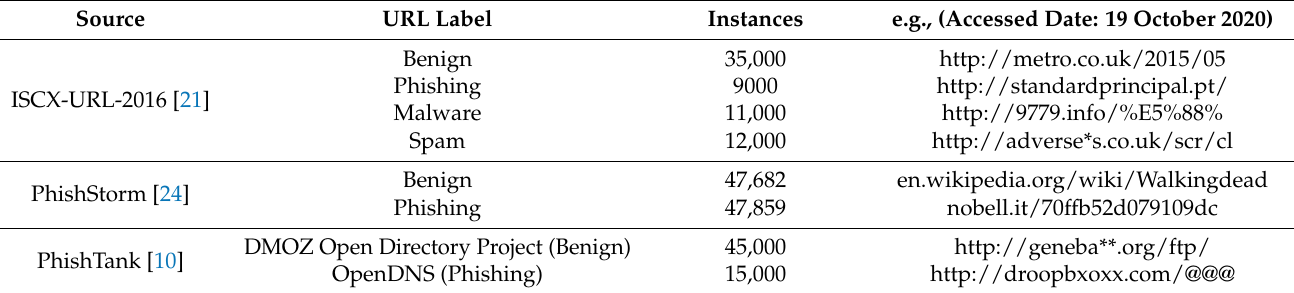
Table 2. Source and description of the three benchmark phishing URL datasets. Source URL